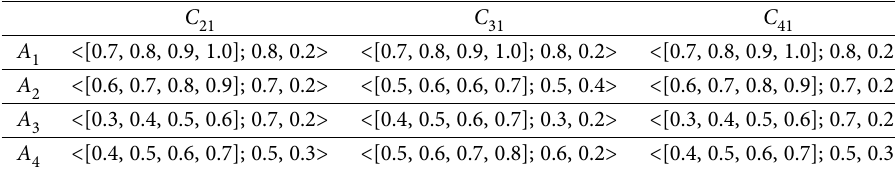
Table 1. Decision-making matrix